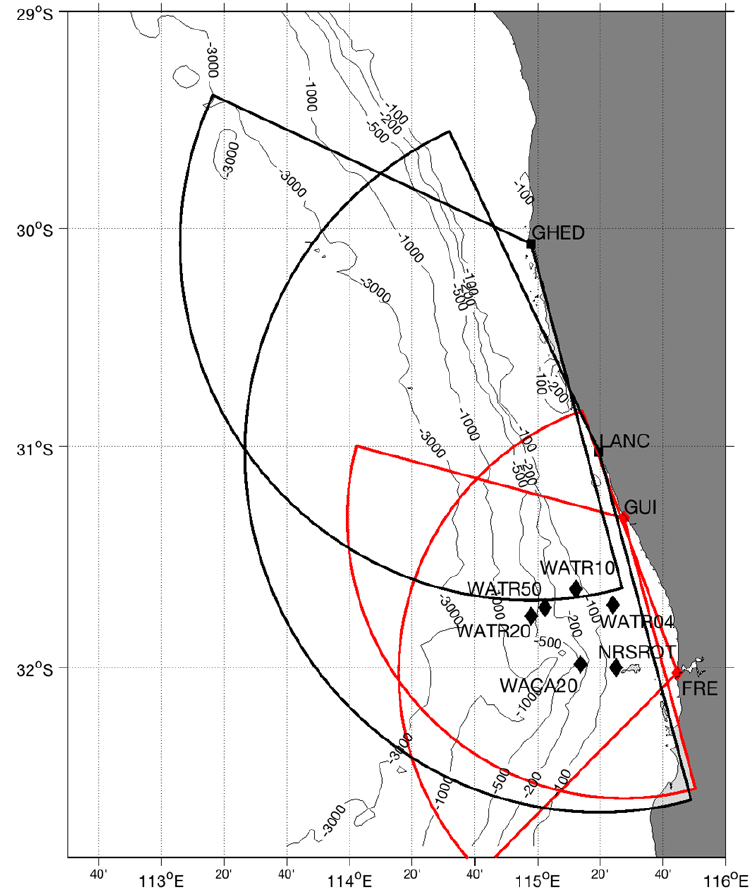
Figure 1. Coverage of the HFR systems in the Rottnest Shelf deployment, WA, with the dominant bathymetric features. Red (black) markers are used for the WERA (SeaSonde) FRE and GUI stations (GHED and LANC); red (black) areas show the typical coverage of each HFR station. Mooring locations are marked as black diamonds inside the WERA HFR footprint.